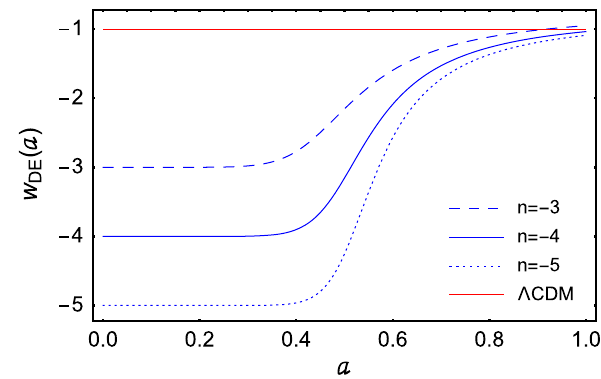
Fig. 2 Evolution of the dark energy EOS parameter w DE ( a ) as a func- tion of the scale factor. It is observed a phantom behaviour along of the cosmic evolution, being that the deviation for higher negative val- ues occurs in the subdominant phase of dark energy. At the present epoch, when dark energy becomes the dominant component, w DE ( a ) may take values which are consistent with observations. For n = − 4 one obtains w DE ( a = 1 ) ≈ − 1 . 04 which is in accordance with obser- vational data, whereas that for n = − 3 and n = − 5 one has that w ( a = 1 ) ≈ − 0 . 949 and w ( a = 1 ) ≈ − 1 . 09, and these DE DE